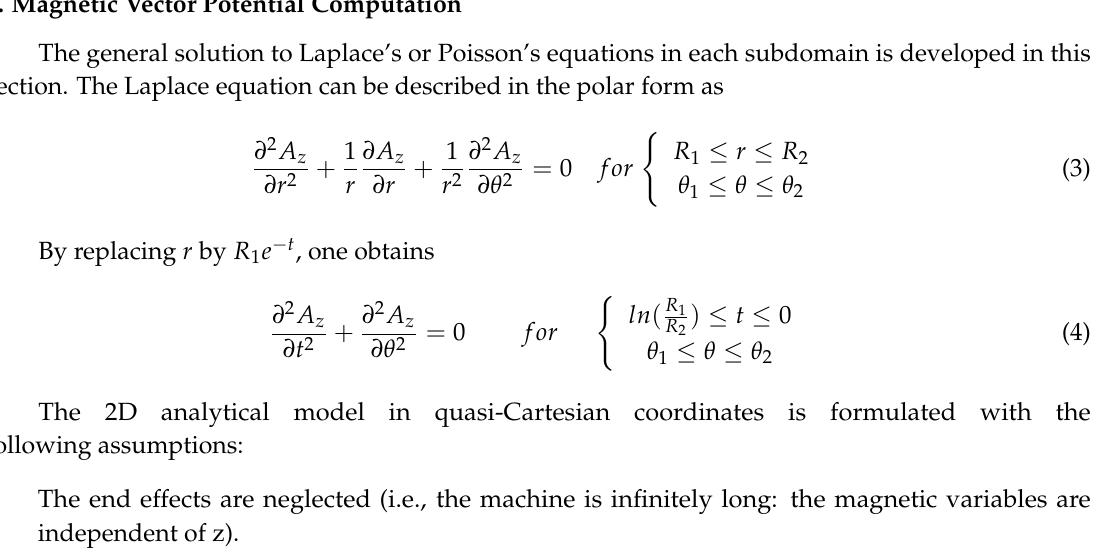
Figure 3. The rotor permanent magnet subdomain. ( a ) Uniform rotor, ( b ) non ‐ uniform rotor.